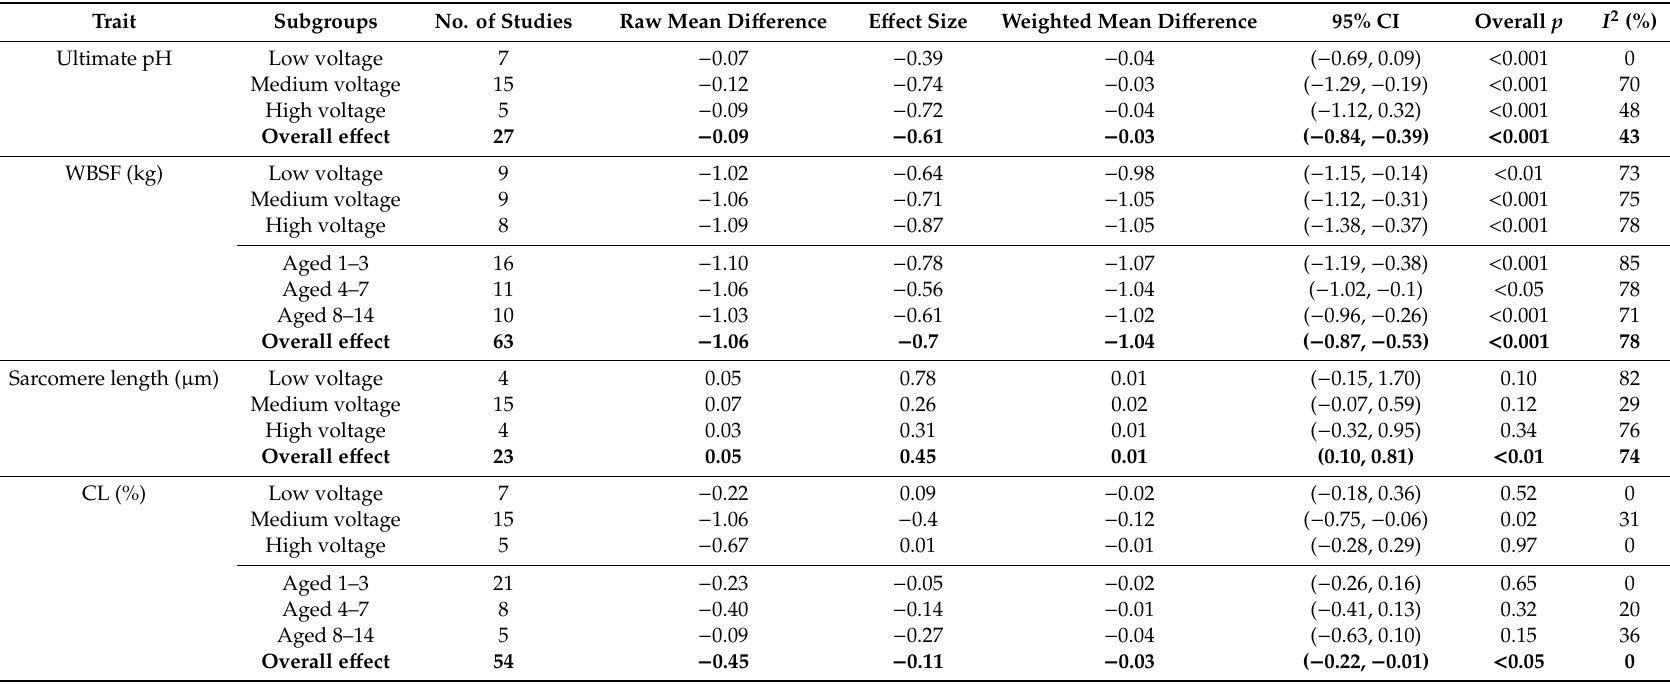
Table 1. Meta-analysis results of e ff ects of electrical stimulation (high, medium, and low voltage) and e ff ect of di ff erent ageing duration (1–3 days, 4–7 days, and 8–14 days) combined with electrical stimulation on ultimate pH; Warner–Bratzler shear force (WBSF, kg); sarcomere length ( µ m); cooking loss (% CL); purge loss (%); L*, a*, b* values; and myofibrillar fragmentation index (MFI) of meat from small ruminants. CI = confidence interval, I 2 = percentile of total variation due to heterogeneity, overall e ff ect, overall p , and e ff ect variance are derived from the random component of the meta-analysis. Minus sign of the overall e ff ect indicates decreased value of the traits in the treatment (electrical stimulation) group, and vice-versa for plus sign. Trait